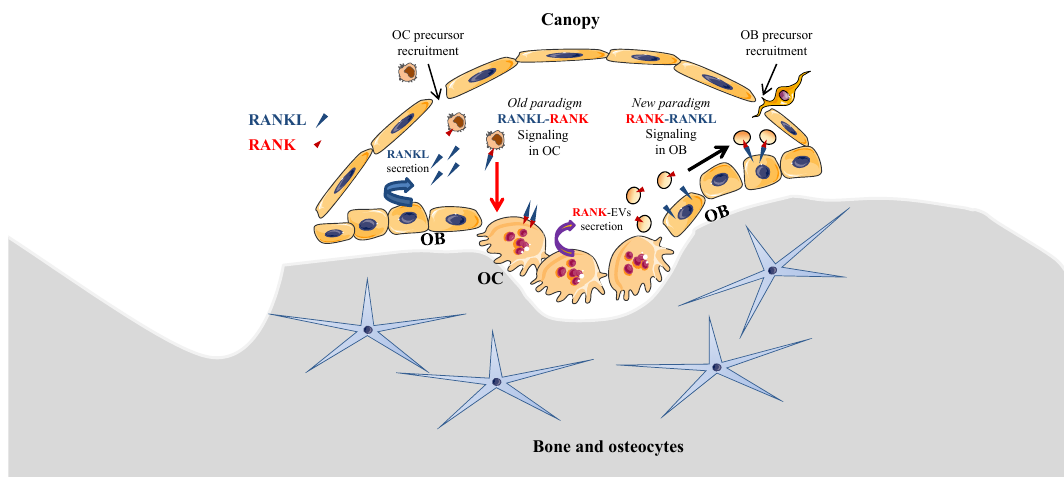
Figure 1. RANK–RANKL interactions under the canopy of bone remodeling compartments: old and new paradigms. The canopy is generated by bone lining cells and insulates a basic multicellular unit with osteoclasts (OC) and osteoblasts (OB). OC and OB precursors are recruited under the canopy, from respectively bone marrow- and blood stream-supplied hematopoietic stem cells and bone marrow-issued mesenchymal stromal cells. In the old and well-demonstrated paradigm, RANKL secreted by OB induces OC di ff erentiation through RANK intracellular signaling (RANKL-RANK), while a new paradigm proposes a reverse signaling through RANKL intracellular signaling (RANK-RANKL) mediated by RANK-bearing extracellular vesicles EVs from OC [32]. RANK: receptor activator of nuclear factor kappa-B; RANKL: RANK